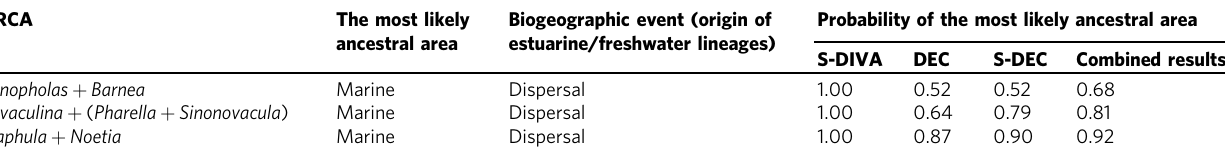
Table 2 Evolutionary origin of bivalve lineages from the freshwater rock-borer community in western Myanmar on the basis of ancestral area reconstruction